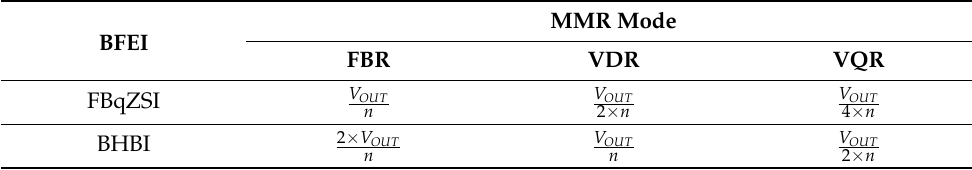
Table 3. Voltage stress of the BFEI